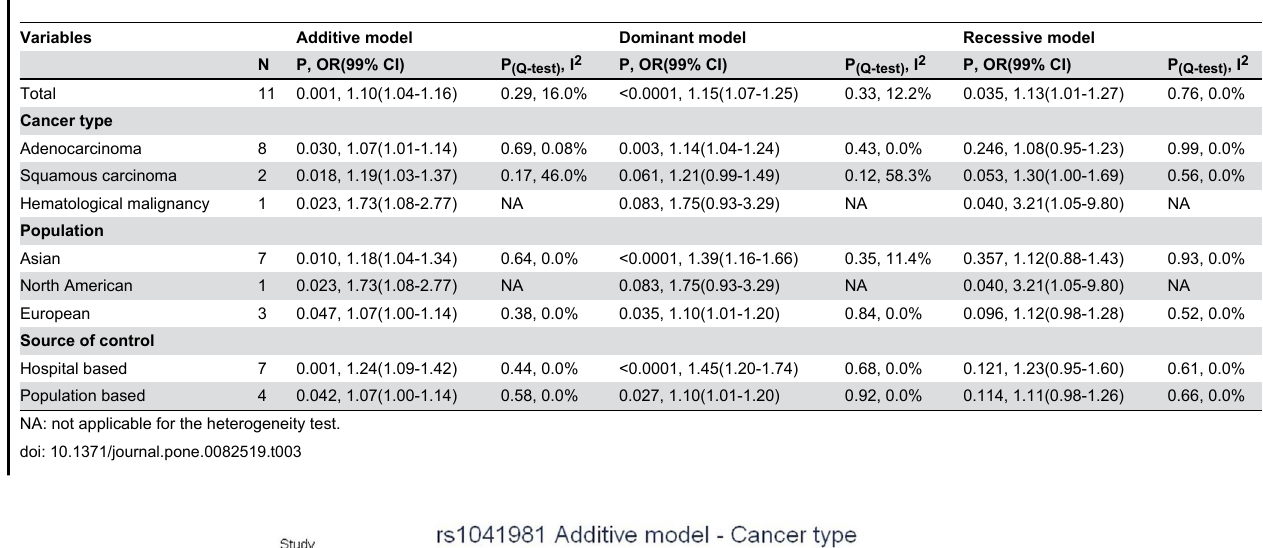
Table 3. Meta-analysis of rs1041981.